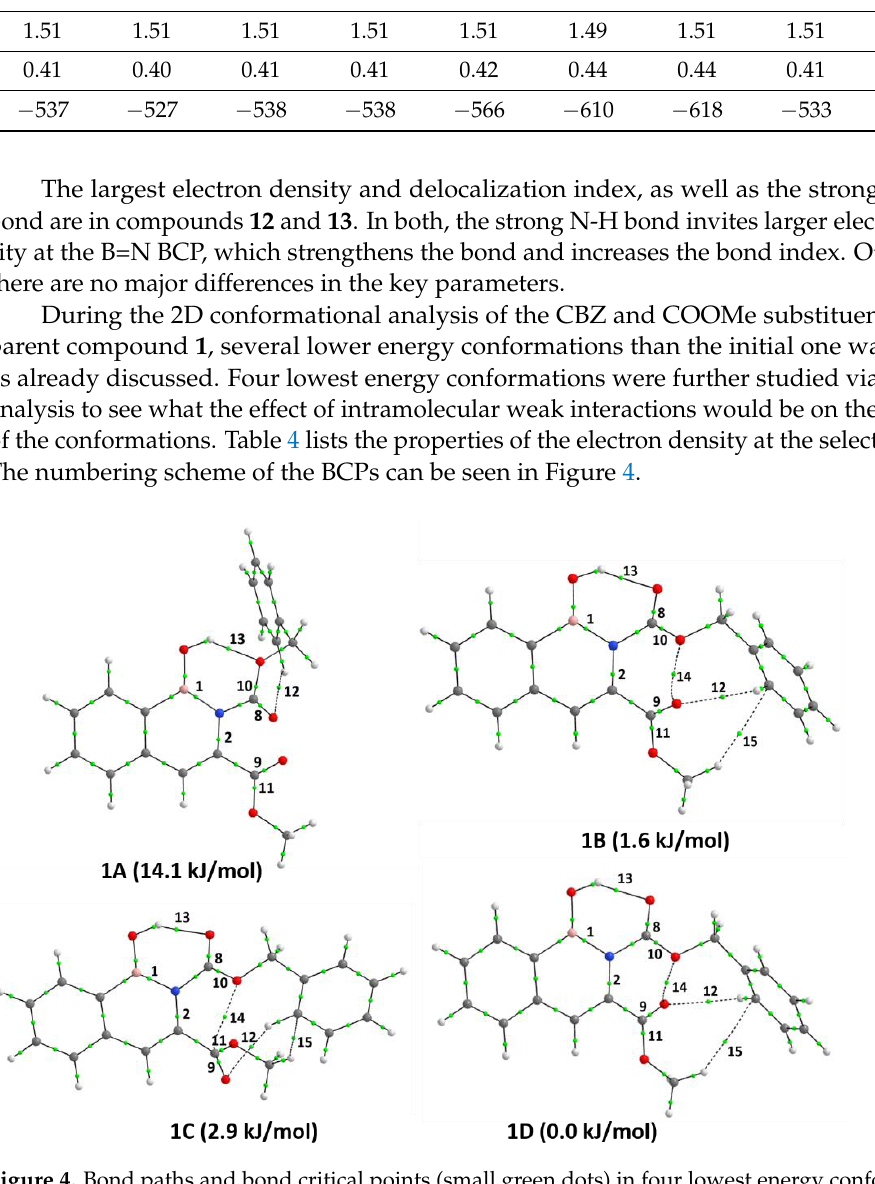
Figure 4. Bond paths and bond critical points (small green dots) in four lowest energy conformations of compound 1 . Table 4. Properties of the electron density at the selected bond critical points (BCPs, see Figure 4) of the four lowest energy conformations of compound 1. The parameters are d = bond distance, ρ = electron density, E = total energy at the BCP.